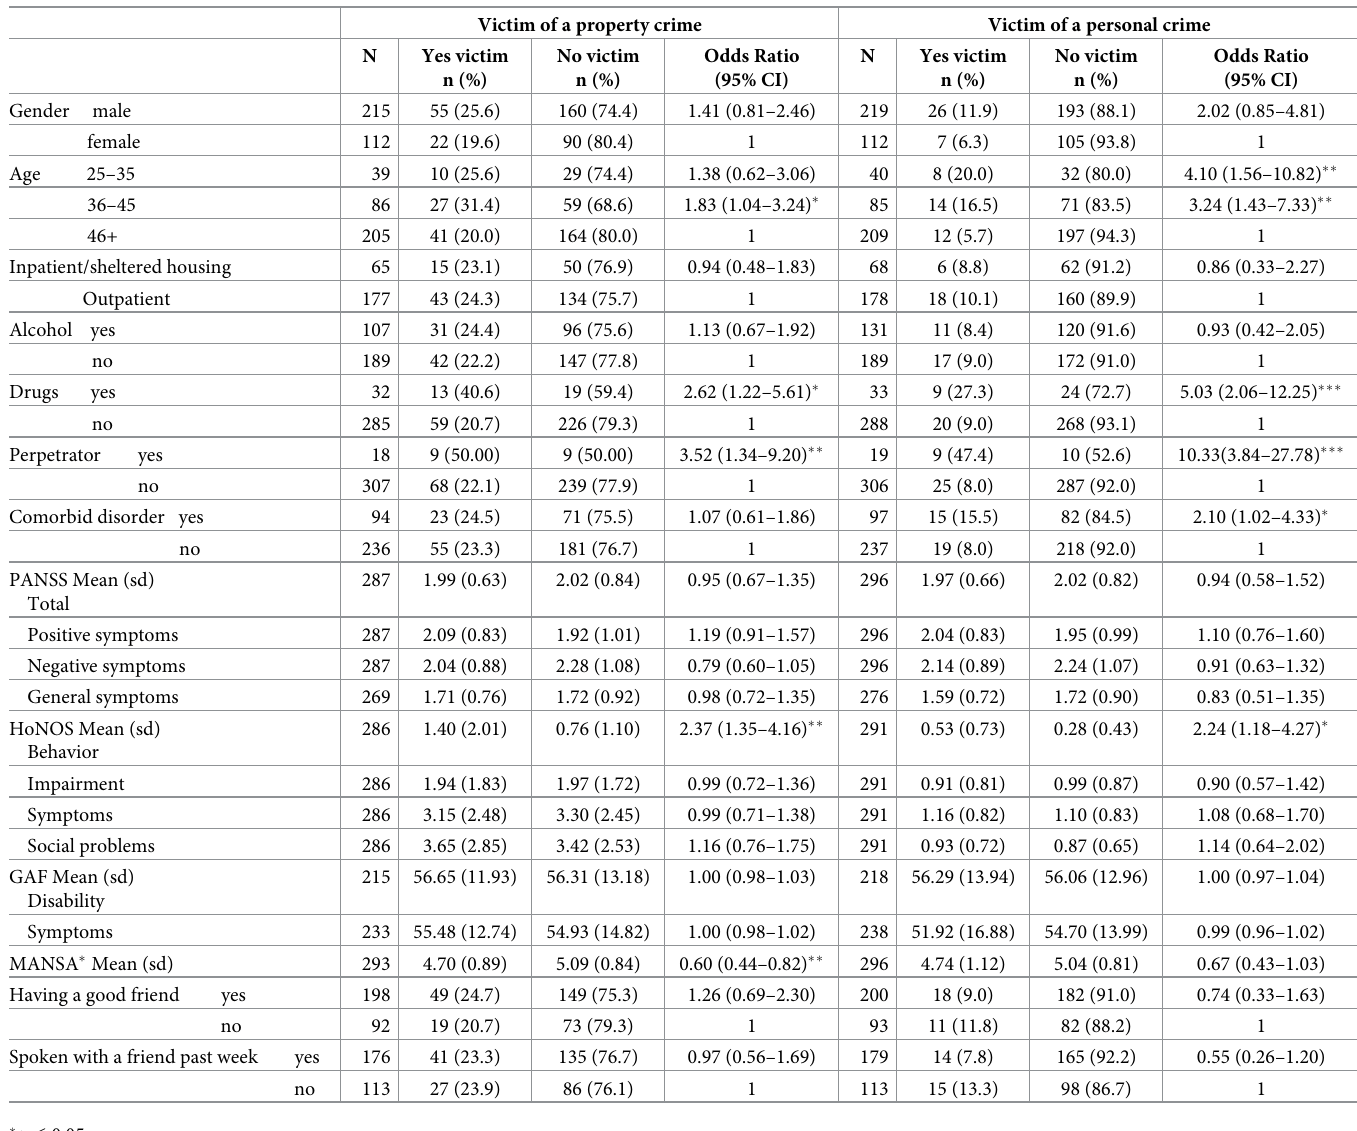
Table 4. Univariate analyses of factors associated with personal and property